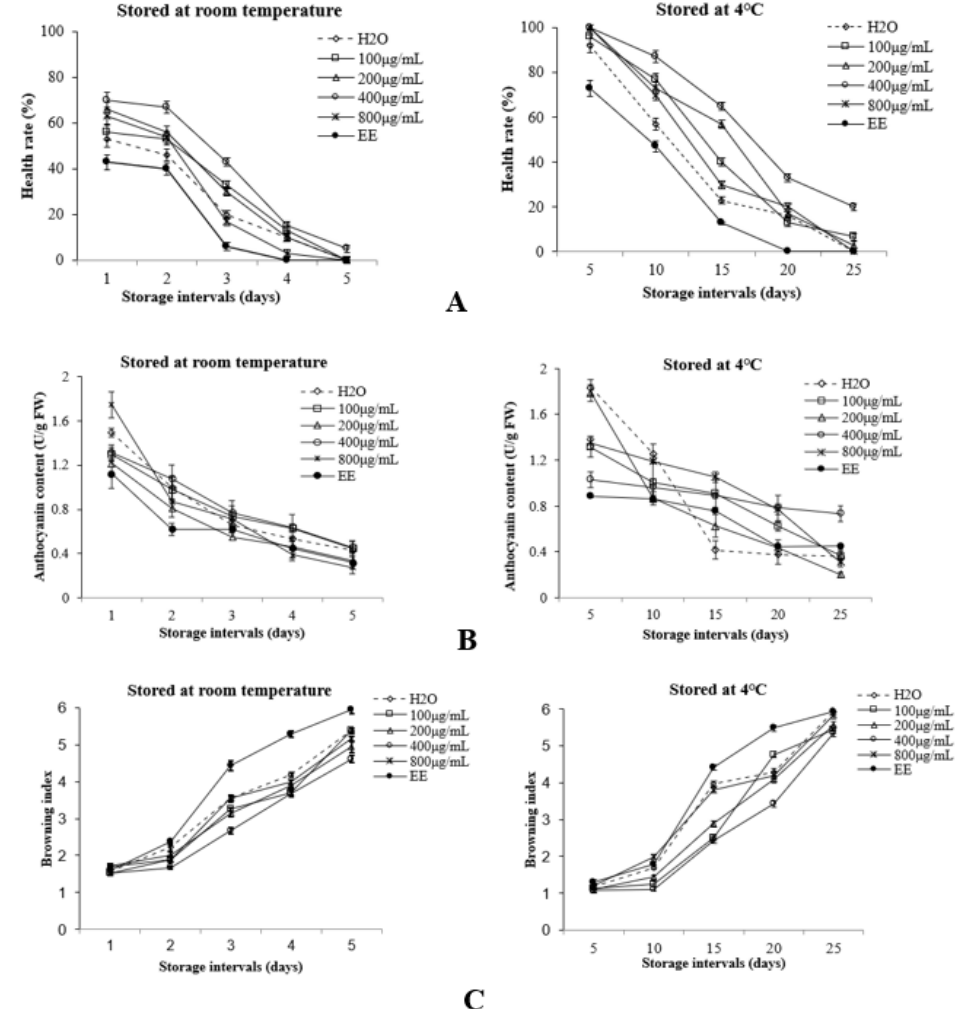
Figure 1. Effects of different treatments on the health rate ( A ), anthocyanin content ( B ), and browning index ( C ) in the pericarp of litchi during storage.